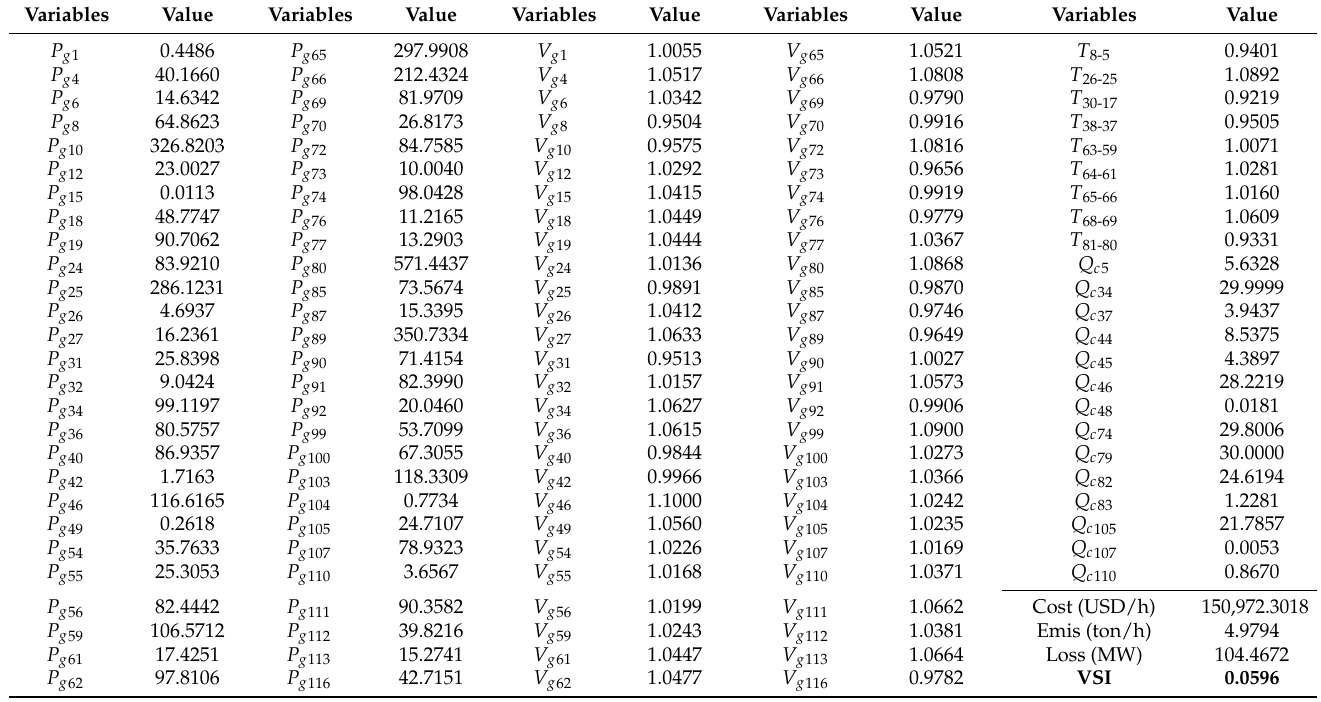
Table A5. Optimal solutions provided by MaMPA when considering VSI as the objective function in the IEEE 118-bus system (case